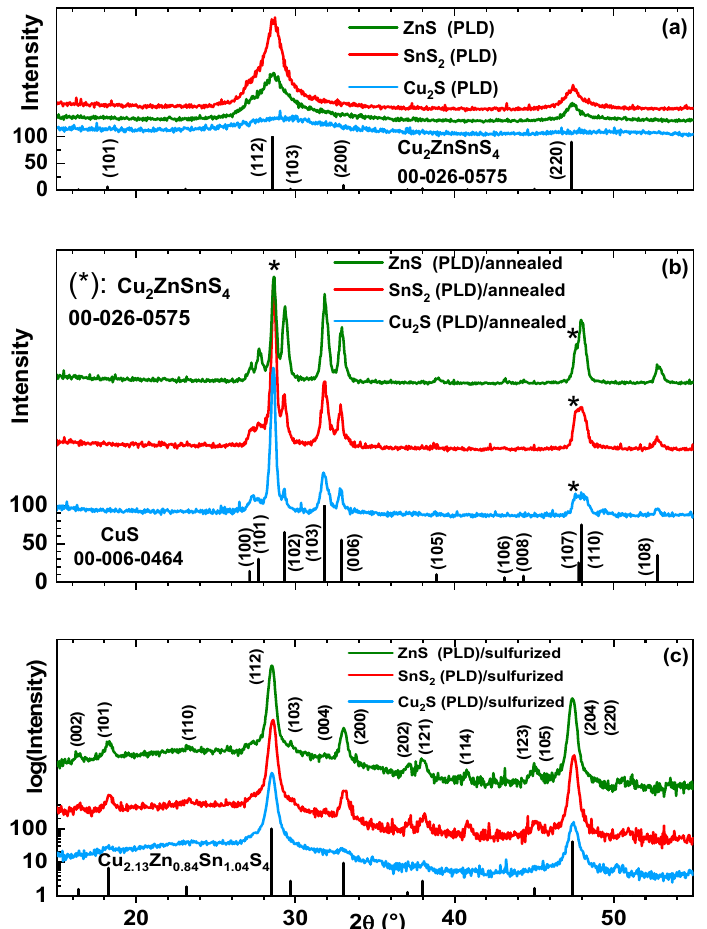
Figure 2. Grazing incidence X-Ray diffraction patterns of the MSPLD thin films ( a ) as-deposited, ( b ) annealed at 500 °C, and ( c ) sulfurized at 500 °C.